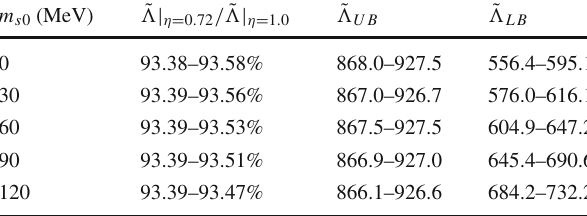
Table 2 Combined tidal deformabilities of strange quark stars for the case of GW170817: the ratio ˜ (cid:2) | η = 0 . 72 / ˜ (cid:2) | η = 1 . 0 , the upper bound of combined tidal deformability ˜ (cid:2) UB , the lower bound of combined tidal deformability ˜ (cid:2) LB , with different strange quark masses m s 0